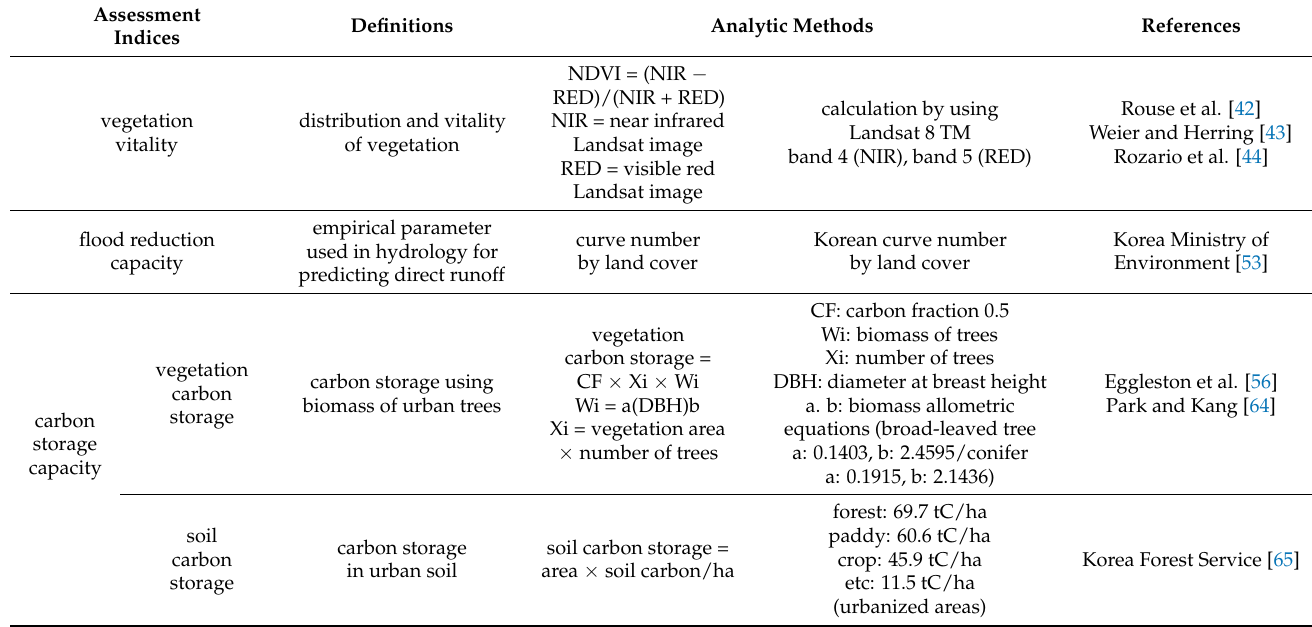
Table 1. Definition and analysis method of the ERS assessment